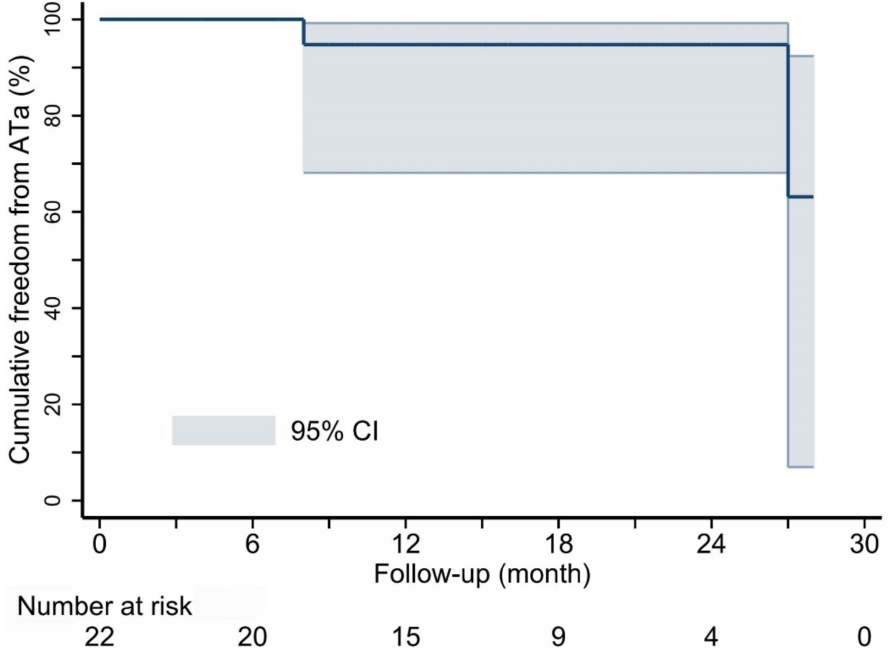
Figure 8. Kaplan-Meier survival curve showing cumulative freedom from atrial tachy-arrhythmia after ablation. ATa, atrial tachy-arrhythmia; CI, confidential